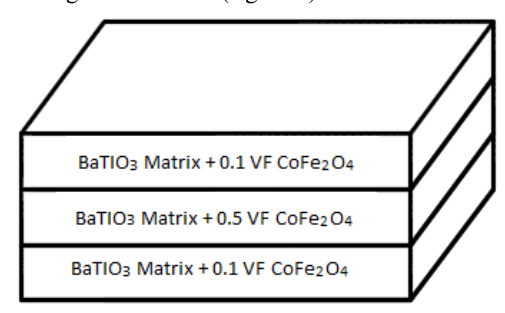
Figure 3: Sandwich multilayer made by piezo-electric matrix with Piezo-electric fiber volume fraction (VF) respectively of 0.1, 0.5 and